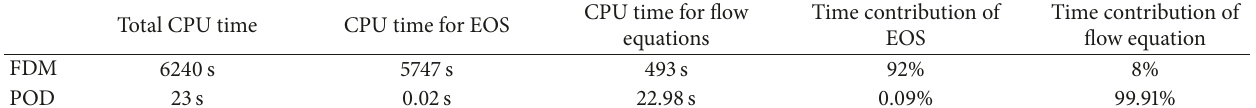
Table 5: Computational time for real gas after improvement.